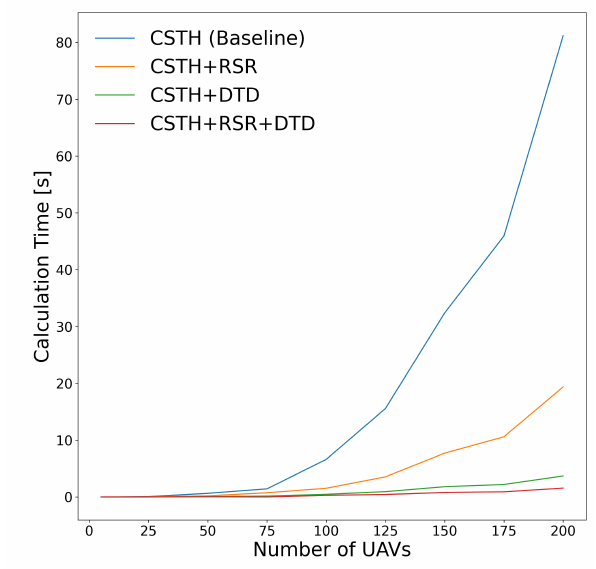
Figure 15. Calculation time for the circular formation when varying the number of UAVs in the